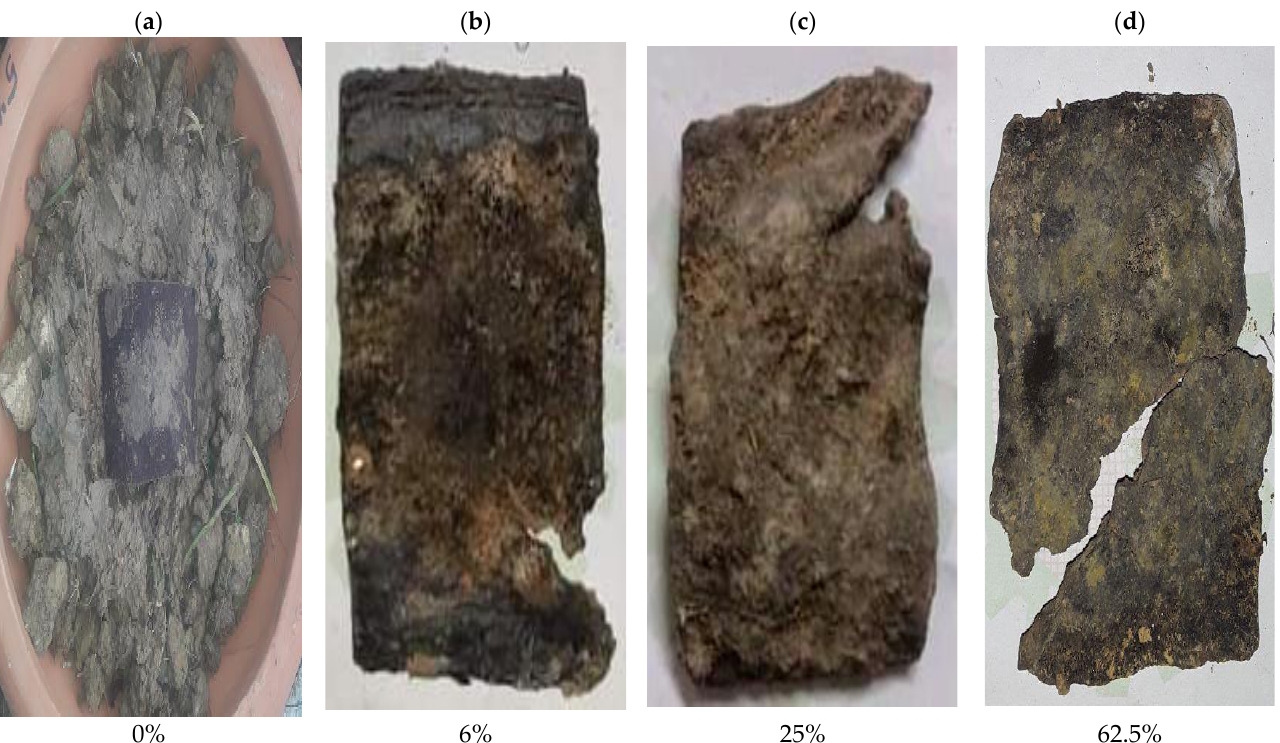
Figure 3. 5% fenugreek containing bio-composite degradation sample on ( a ) Day 1, ( b ) Day 7, ( c ) Day 15, and ( d ) Day 30.